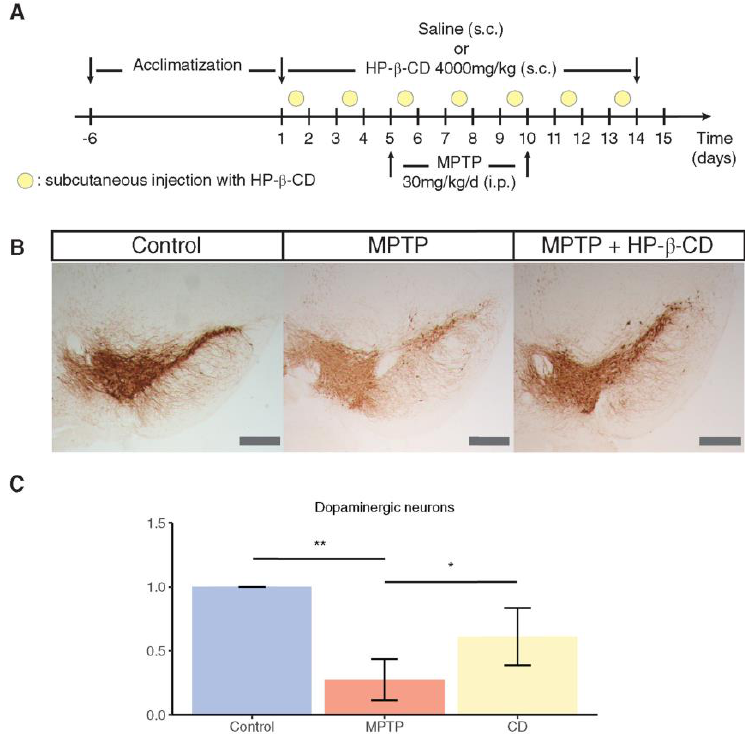
Figure 5. Treatment with HPβCD (represented as HP - β -CD in this figure) protects against toxicity of MPTP. ( A ) Treatment scheme for the generation of MPTP- induced subacute Parkinson’s disease mice model and subsequent treatment with HPβCD. ( B ) Representative mouse midbrain sections stained for tyrosine hydroxylase (TH) in control, MPTP or HPβCD - treated mice (bar = 400 μm). ( C ) Stereological quantification of the TH levels in mouse sections normalised to control